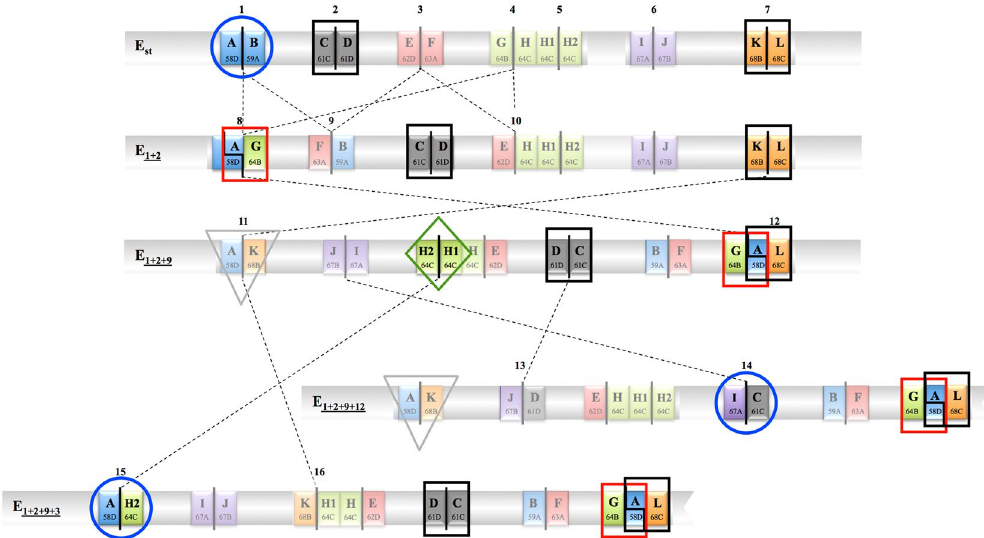
Figure 2. Schematic representation of the five E chromosome arrangements considered in this study and their breakpoint regions. Discontinuous lines connecting two chromosomal arrangements indicate the inversions that differentiate them. On each chromosomal arrangement, the breakpoints involved in inversions E 1 , E 2 , E 9 , E 3 and E 12 are indicated, although only those used for karyotyping are highlighted. Circles indicate fragments exclusive of one arrangement (fully diagnostic). Rectangles indicate fragments that are shared by two or more arrangements. Inverted triangles indicate an initially used fragment (AK) that later was discarded due to its high failure to amplify frequency. A rhombus indicates a fragment that is only used to discern between the E 1 + 2 + 9 + 3 / E 1 + 2 + 9 + 3 and E 1 + 2 + 9 /E 1 + 2 + 9 + 3